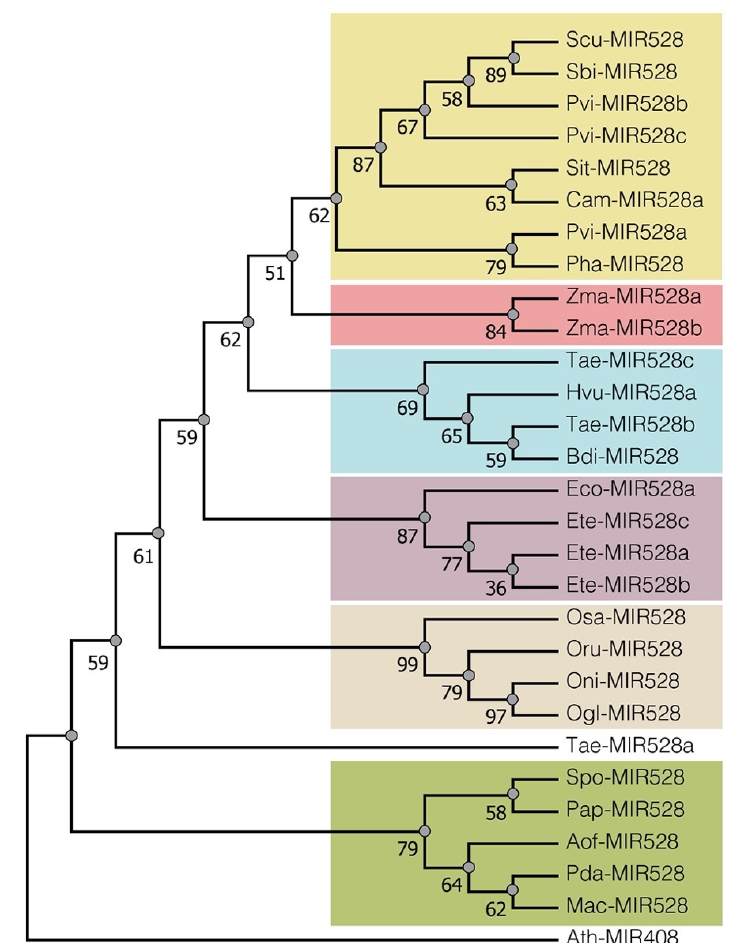
Figure 1. Phylogenetic analysis of pre-miR528 sequences found in monocots. Phylogenetic reconstruc- tion was made with MEGA X using the Maximum Likelihood (ML) method and the best-adjusted model ( 3-parameter Tamura ) with 1000 bootstrap iterations. Twenty-eight monocot miR528 precursor sequences were clustered in different subclades using the ggtree package in R studio. Arabidopsis thaliana miR408 precursor was used as an outlier with an equivalent function, as this miRNA shared several targets with miR528 [20]. The bootstrap values are marked as numbers at nodes. Aof: